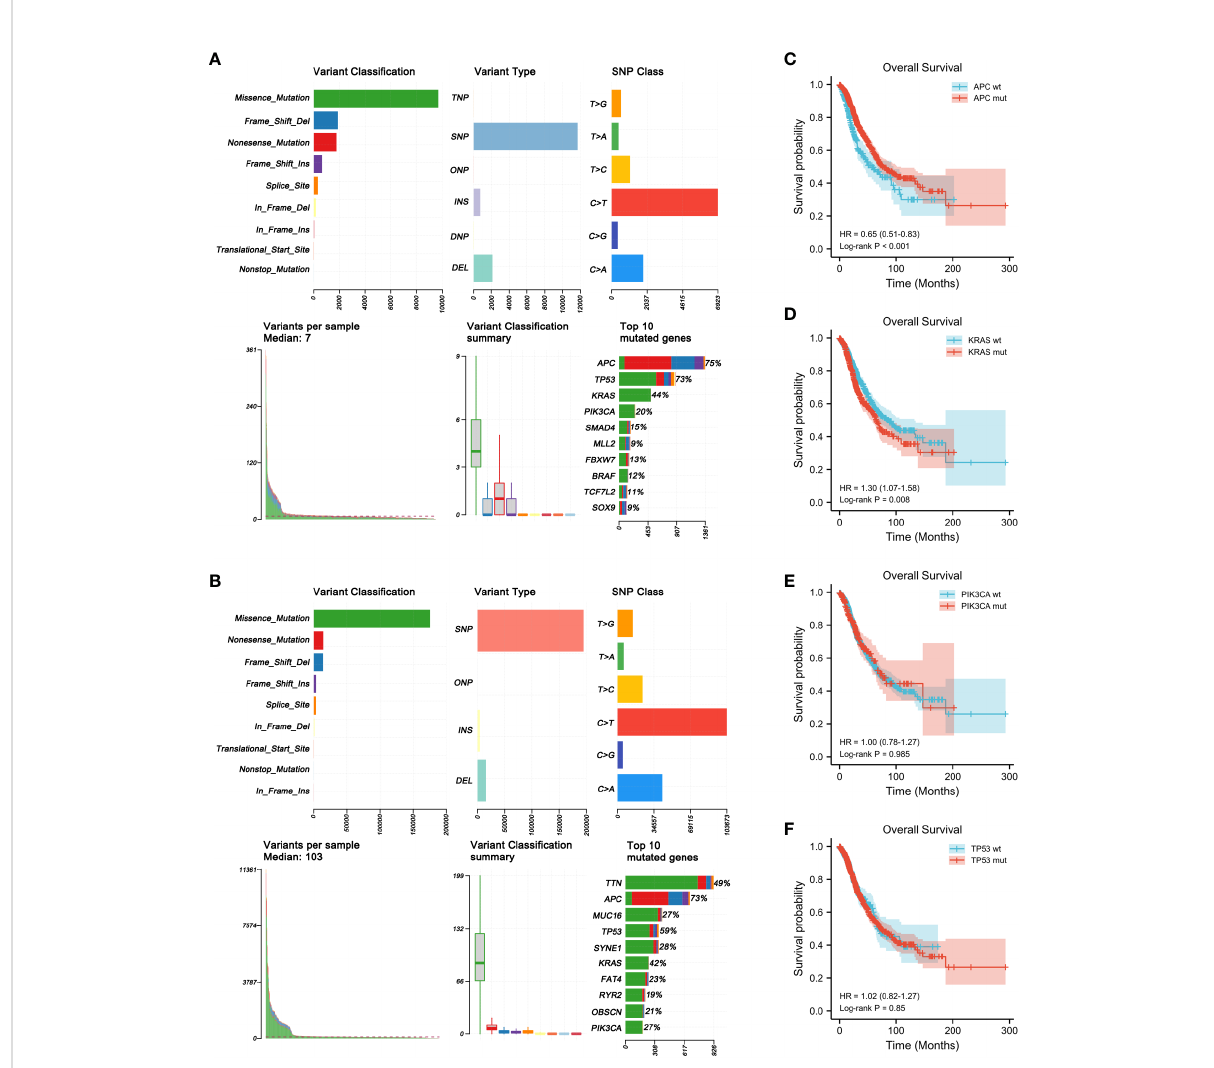
FIGURE 1 Genome-wide mutation pro fi ling of patients with colorectal cancer (CRC). (A, B) Cohort summary plots for the Memorial Sloan Kettering Cancer Center (MSKCC) (A) and The Cancer Genome Atlas (TCGA) (B) cohorts displaying the distribution of variants according to variant classi fi cation, type, and single nucleotide variation (SNV) class. The bottom panel (from left to right ) indicates the mutation load for each sample and variant classi fi cation type. A stacked bar plot shows the top 10 mutated genes. (C – F) Kaplan – Meier analysis showing the impact of gene mutations on the overall survival (OS) of patients with CRC (1,653 patients from the MSKCC and TCGA cohorts with complete OS data). (C) CRC patients with APC mutations had longer OS than those with wild-type APC (HR = 0.65, p < 0.001). (D) CRC patients with KRAS mutations had shorter OS than those with wild-type KRAS (HR = 1.30, p = 0.008). (E, F) PIK3CA (HR = 1.00, p = 0.985) (E) and TP53 (HR = 1.02, p = 0.850) (F) mutations had no obvious effect on the OS of patients with